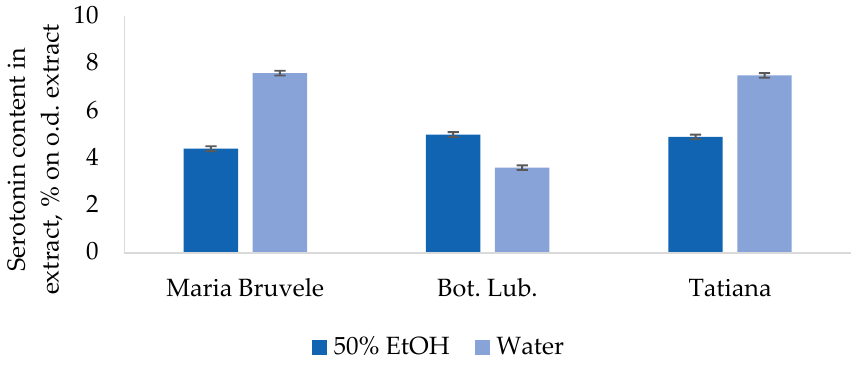
Figure 10. Content of serotonin in extracts from SBT biomass. Data presented as mean ± SD ( n = 3). CI ≤ 0.04 at α = 0.05.